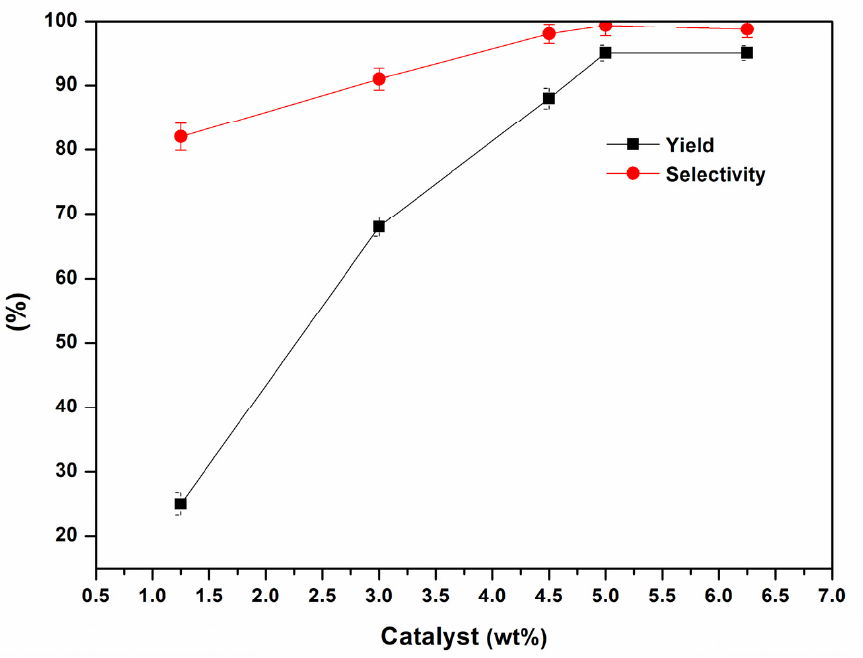
Figure 1. Effect of amount of catalyst on the reaction. Reaction conditions: 2-methylaziridine (10 mmol), CO 2 (0.7 MPa), MCM-41@ILLaCl 4 , 50 °C, 3 h.